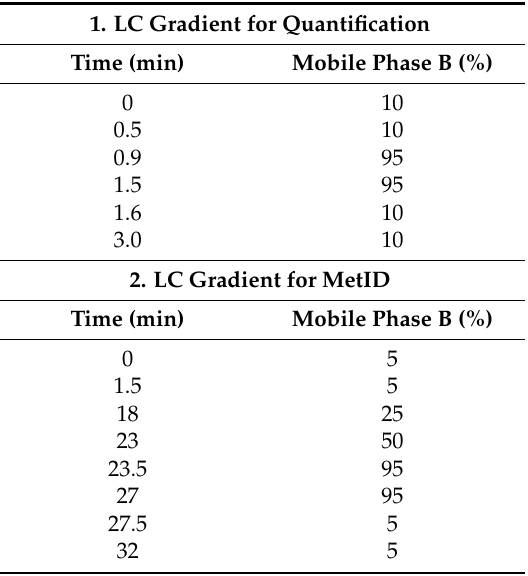
Table 1. The mobile phase conditions for LC (Liquid-Chromataography)